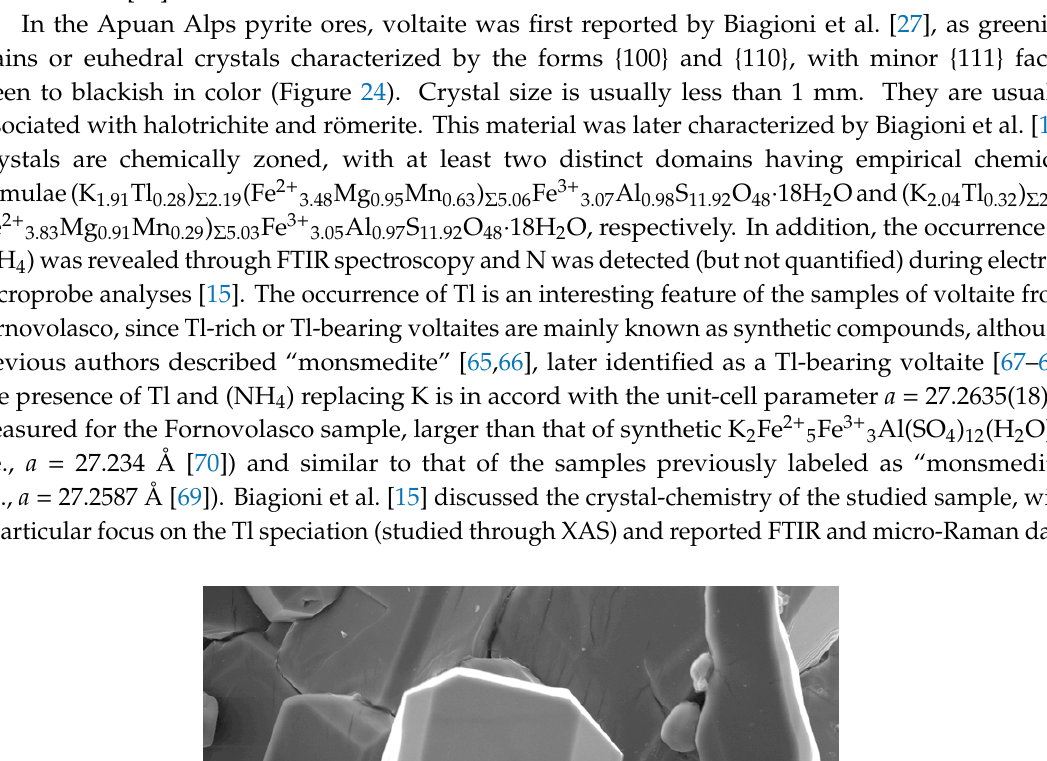
Figure 25. Voltaite from the Monte Arsiccio mine, as up to 2 cm-sized octahedral crystals. 3.22. Wilcoxite Wilcoxite is a rare fluo-sulfate, ideally MgAl(SO 4 ) 2 F(H 2 O) 11 ·6H 2 O. Its occurrence in the secondary assemblages from the pyrite ores of the Apuan Alps was reported by Mauro et al. [28] on samples from the Fornovolasco mine, where wilcoxite occurs as colorless to whitish crystals, in some cases showing rounded edges, up to 5 mm across (Figure 26), associated with epsomite, gypsum, and an intermediate member of the halotrichite-pickeringite series [28]. Qualitative chemical analyses, performed in EDS mode, showed Mg, Al, S, F, and minor Fe as the only elements with Z > 8 above the detection limit. SC-XRD data pointed to a triclinic unit cell, with a = 6.6749(4), b = 6.7730(4),